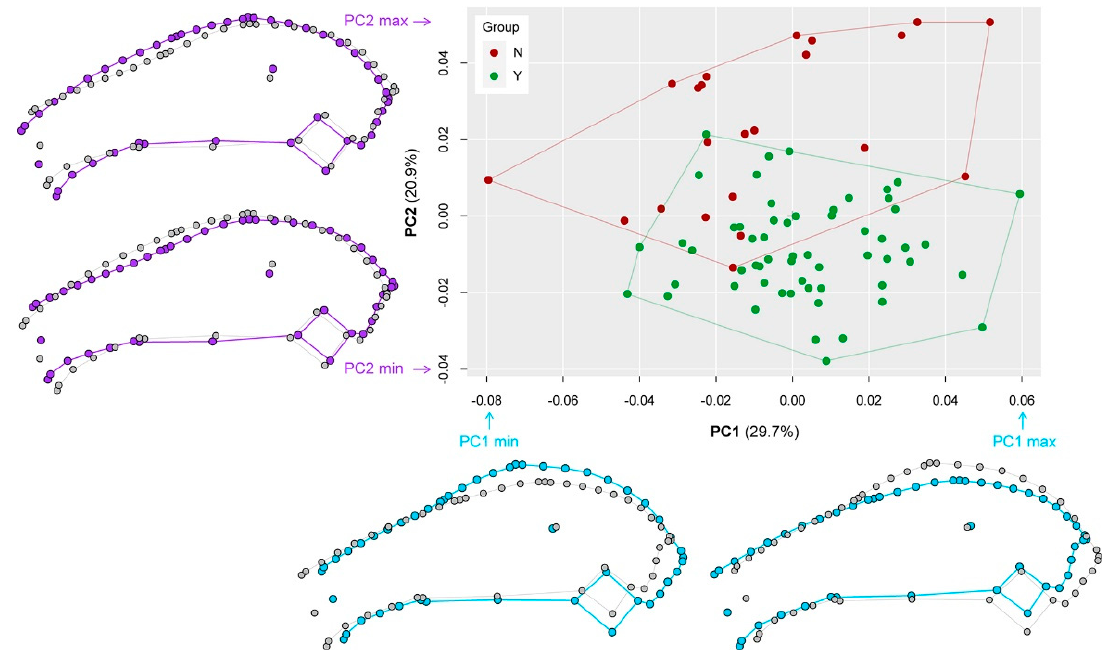
Figure 7. Results of the geometric morphometric analysis. The scatterplot displays the distribution of the sampled specimens in the morphospace represented by the first two principal components (PC1 and PC2). The percentage of explained variance by each PC is indicated in parentheses. The outlines visualize the shape differences between the extreme configurations (min = minimum, max = maximum) along PC1 and PC2.